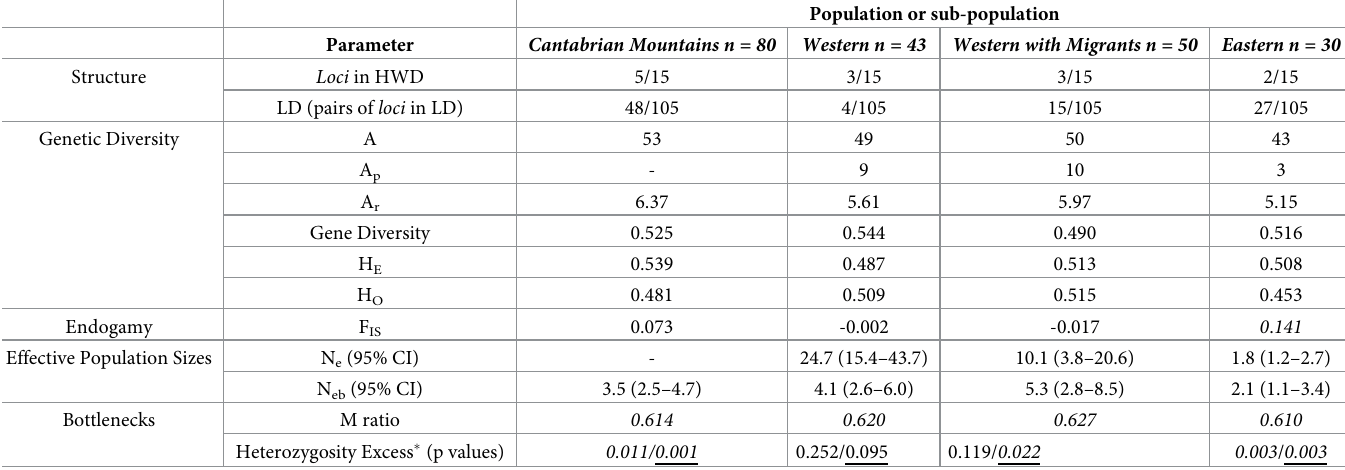
Table 1. Genetic diversity indices for the Cantabrian brown bear population and its subpopulations, based on 15 microsatellite markers. Numbers of loci or pairs of loci with significant deviations from Hardy-Weinberg equilibrium and linkage equilibrium conditions after Bonferroni correction are shown. Significant values are in